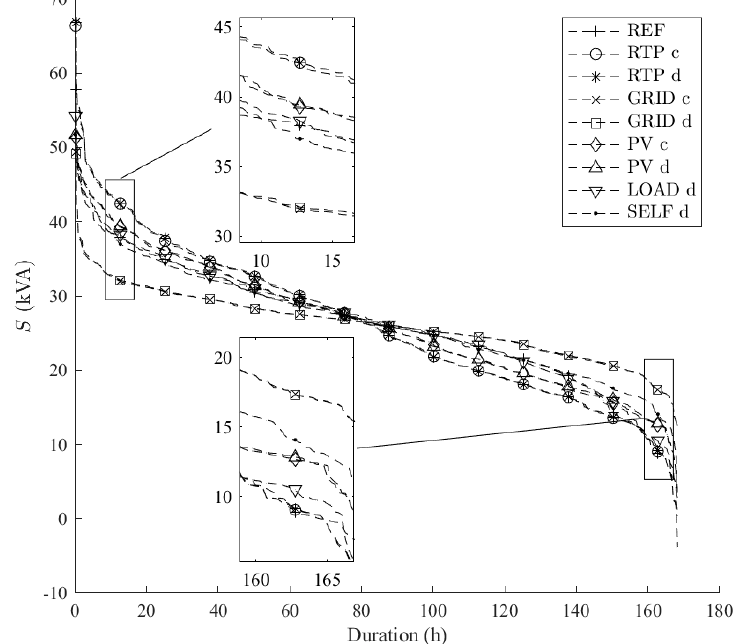
Figure 4. Power duration curve for a single, central storage (c) and multiple, distributed storages (d) driven by different incentives.